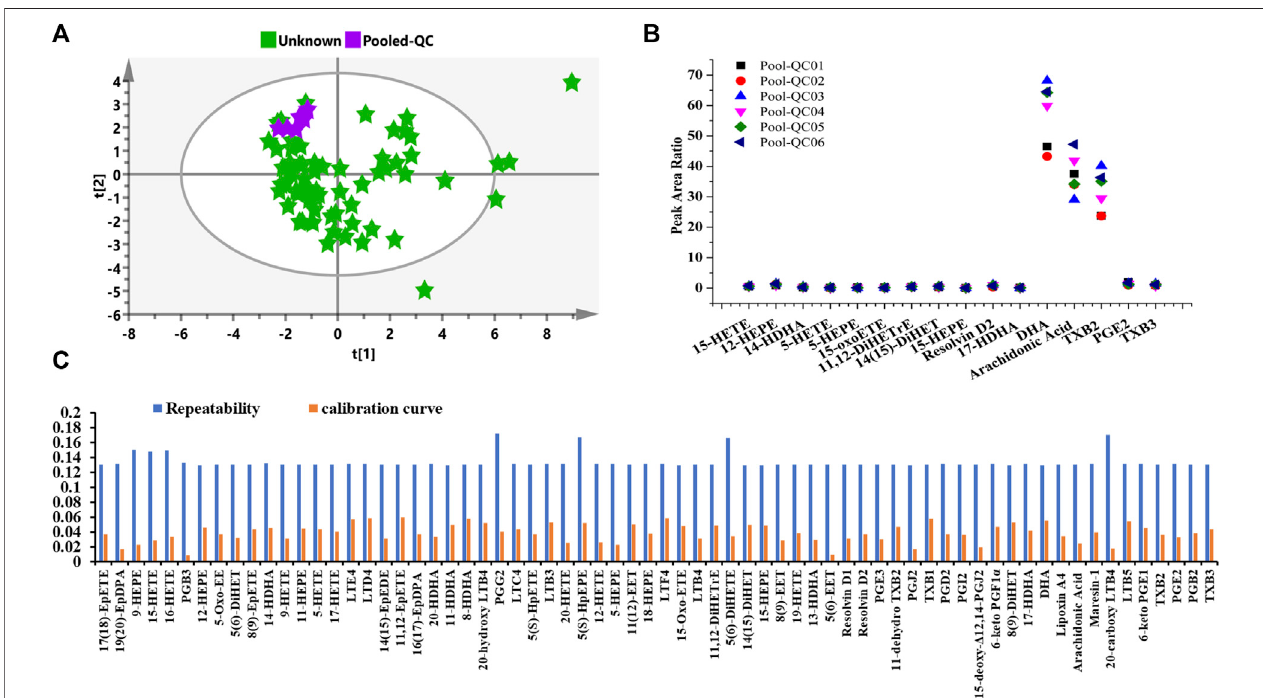
FIGURE 7 | Quality control performance and uncertainty measurement for the eicosanoid metabolic quantitation. (A) Unsupervised PCA score of pooled QC plasma samples. (B) Control chart of pooled QCs in the present study. (C) Uncertainty of measurement of solution QC sample at a concentration of 1 ng/ml regarding quantitative repeatability and calibration